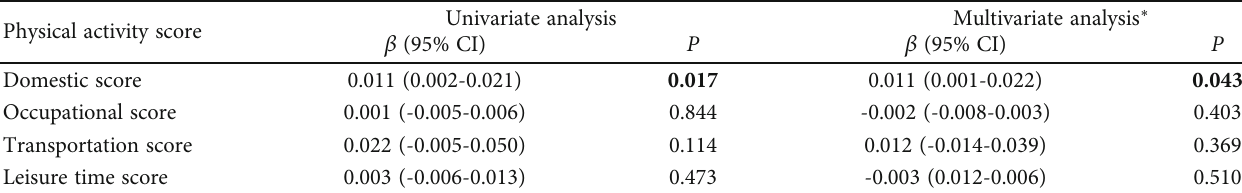
Table 2: Univariate and multivariate analysis of factors in fl uencing cognitive functioning.